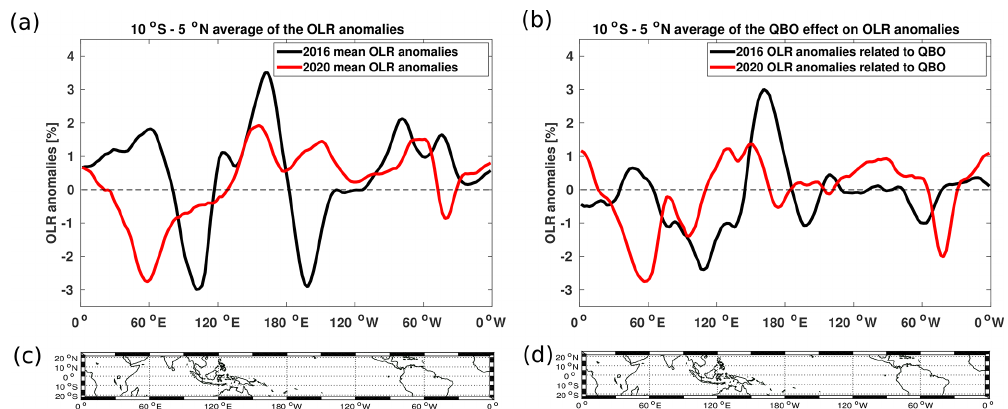
Figure 7. Longitudinal variations of the monthly mean outgoing longwave radiation (OLR) anomalies (a) averaged between 20 and 20 ◦ S together with the 2016 and 2020 QBO effects (b) associated with the convective activity derived from the multiple regression fit. The lowermost panels (c, d) show the tropical region where the OLR time series are